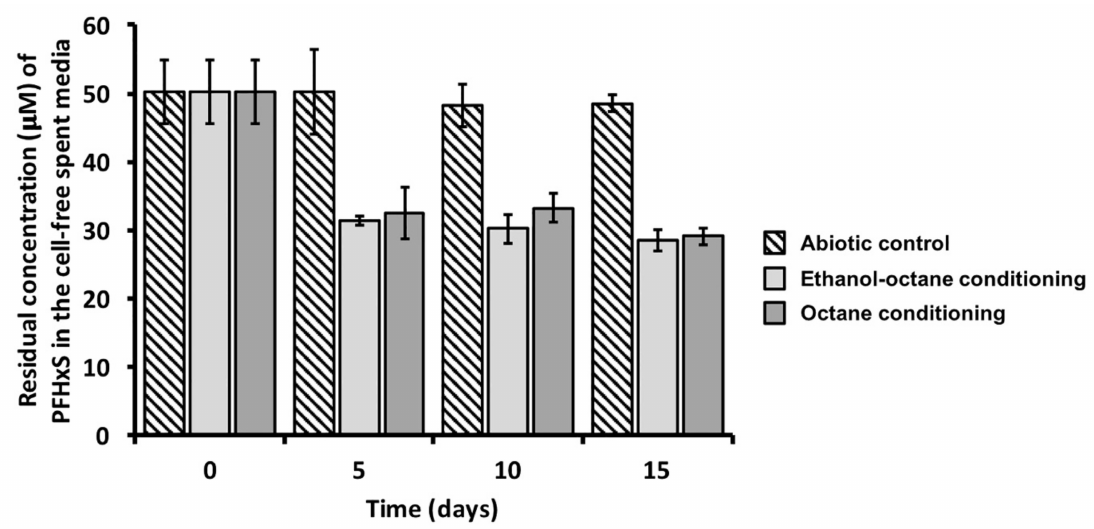
Figure 6. Removal e ffi cacy of PFHxS performed by the mixed microbial culture under either ethanol-octane or octane conditioning.